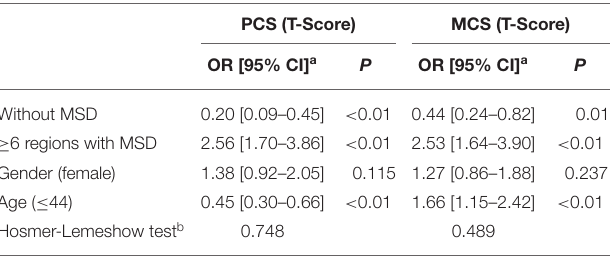
TABLE 6 | Logistic regression to evaluate the association between the physical and mental health components of quality of life with the absence of MSD and greater equal to six painful regions ( ≥